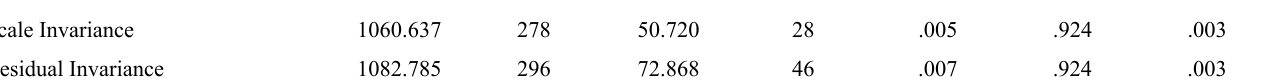
Table 4 Fit indices for the invariance of the measurement model of the PLOCQ in the Portuguese sample across samples, gender, 3 rd cycle and secondary cycle χ² df ∆ χ² ∆df p CFI ∆CFI CS - VS Conigural Invariance